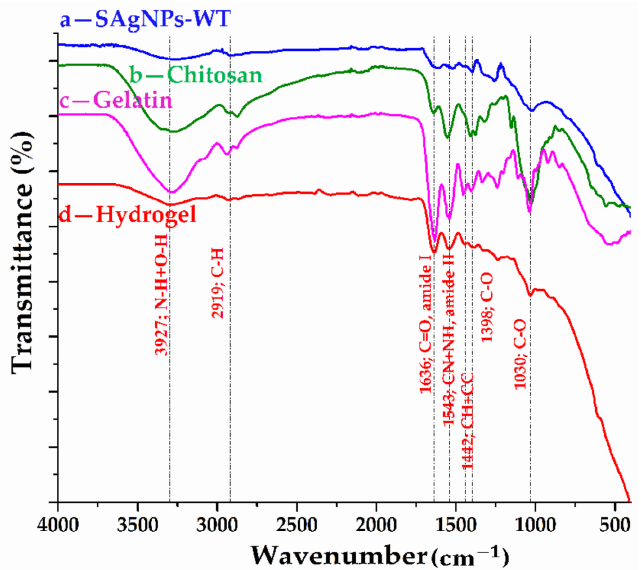
Figure 7. ATR-FTIR spectra for (a) silver nanoparticles from willow tree; (b) chitosan; (c) gelatin; and (d) hydrogel with silver